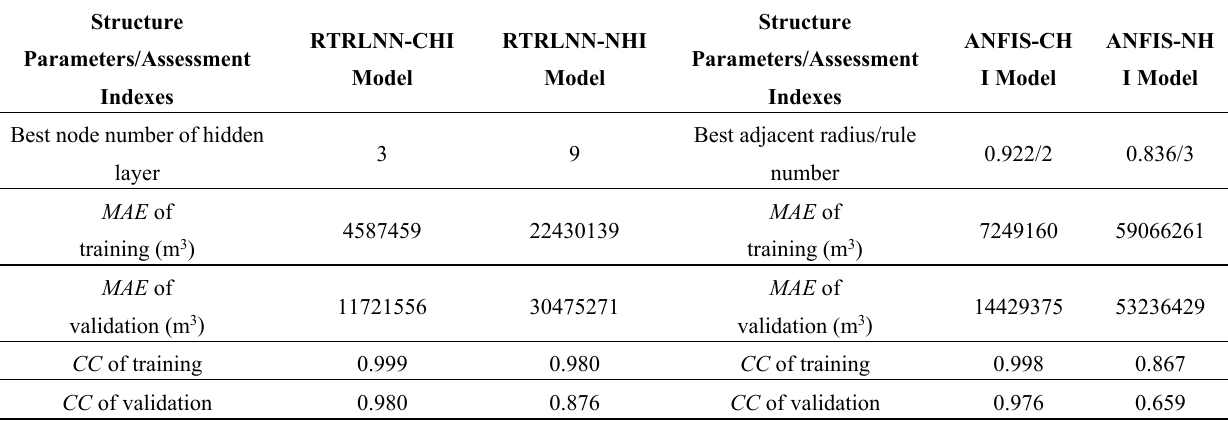
Table 2. Best assessment indexes values of the four kinds of constructed